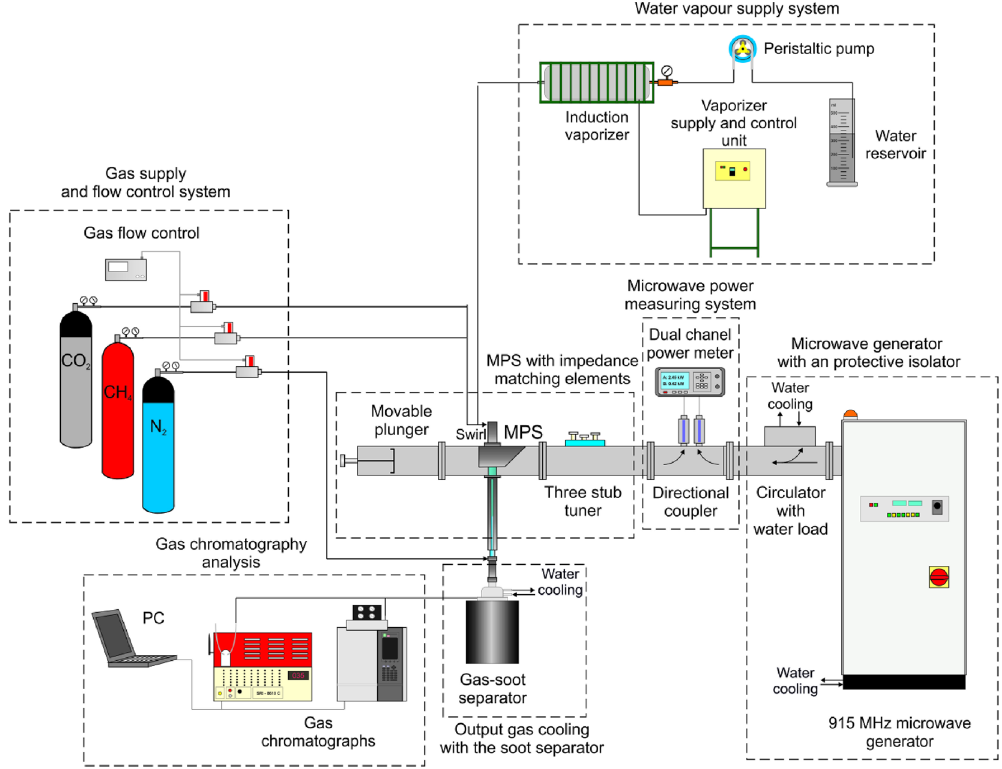
Figure 1. Experimental